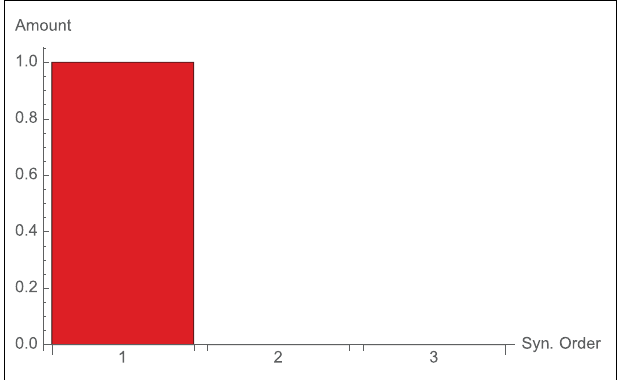
FIGURE 9 | Synergies of different orders for the XorLoses channel, Example 3.6 .